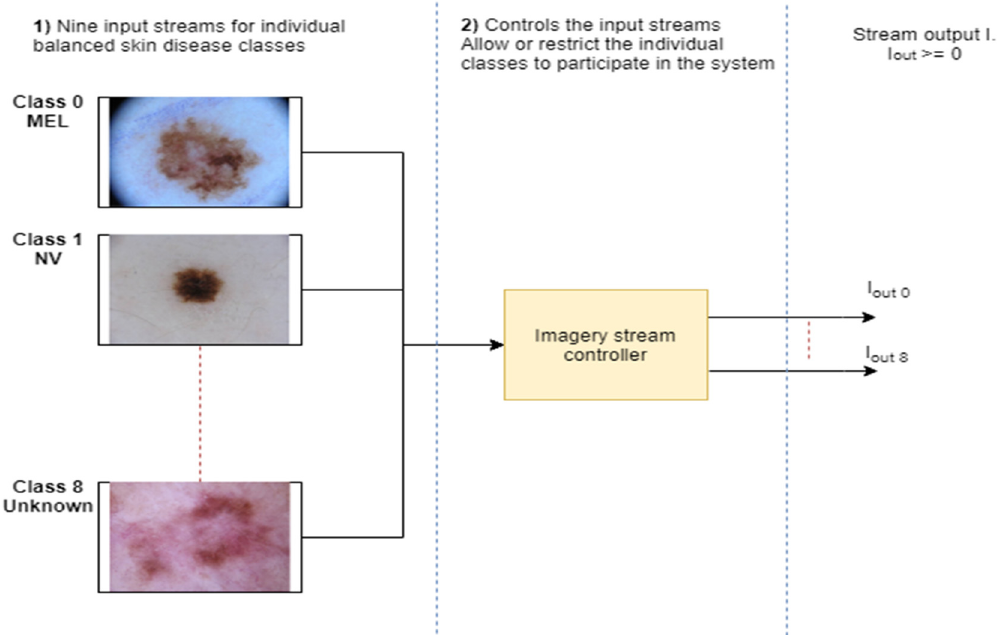
Figure 6. Skin disease dataset stream to simulate the concept drift scenarios.